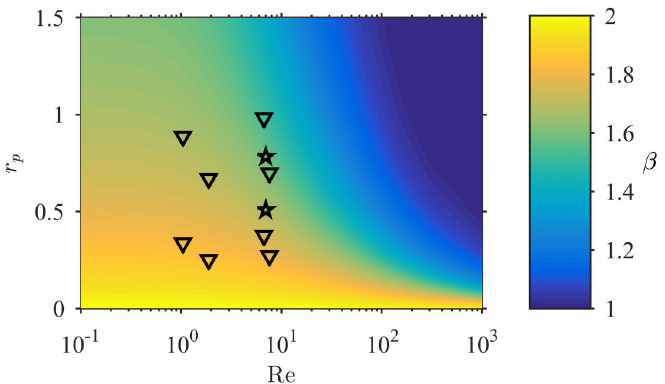
β ), over the p ) and suspended (lower r ) particles in the brittle p p